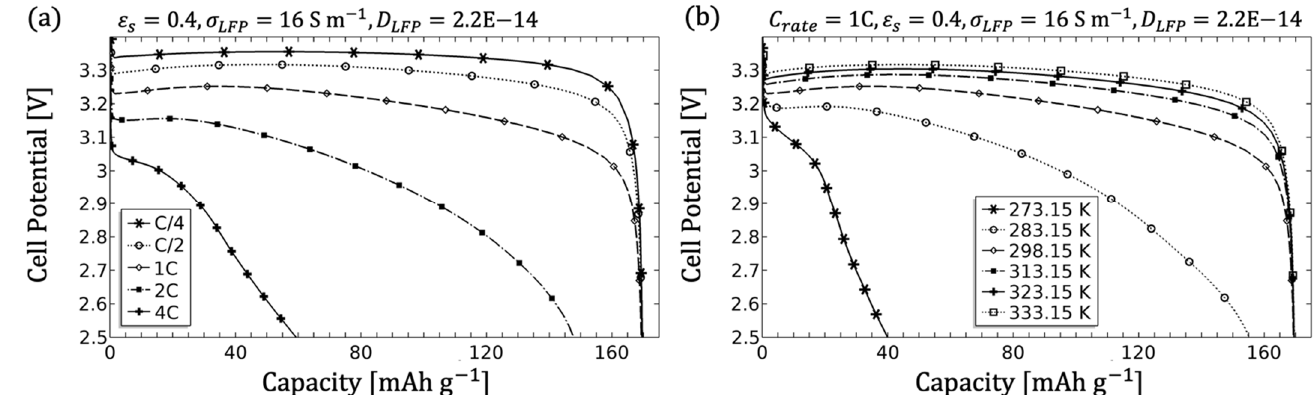
Figure 14. Performance test of the single-structured electrode; ( a ) shows the discharge performance from C/4 up to 4C and ( b ) the temperature dependency from 273.15 up to 333.15 K at 1C.